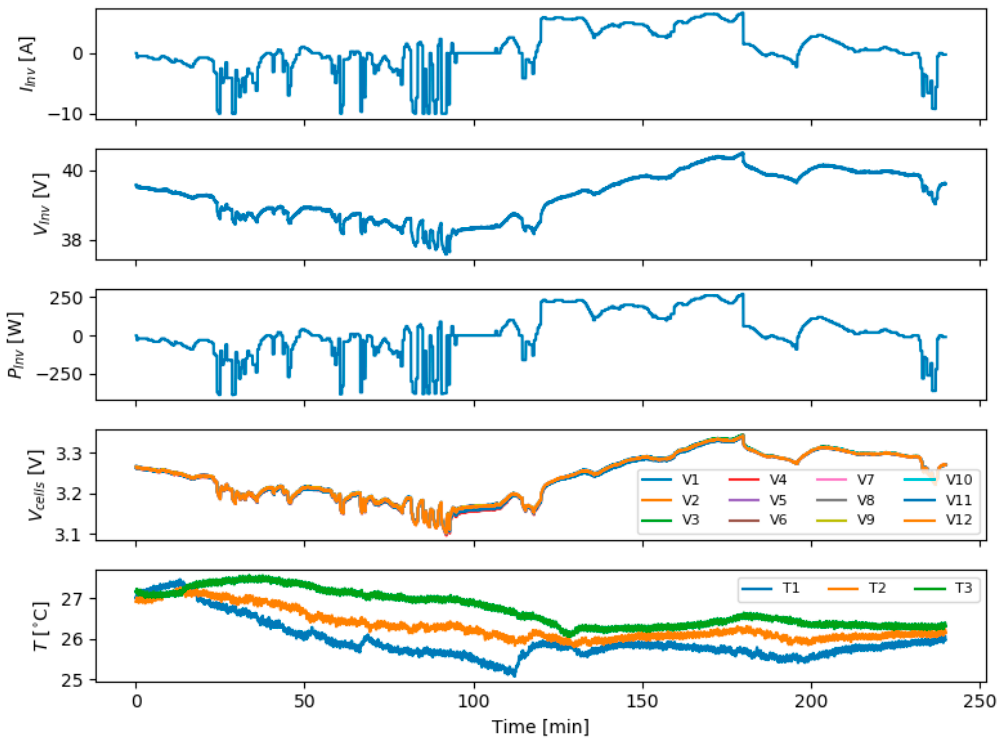
Figure 13. Test result of the applied firming renewable profile.